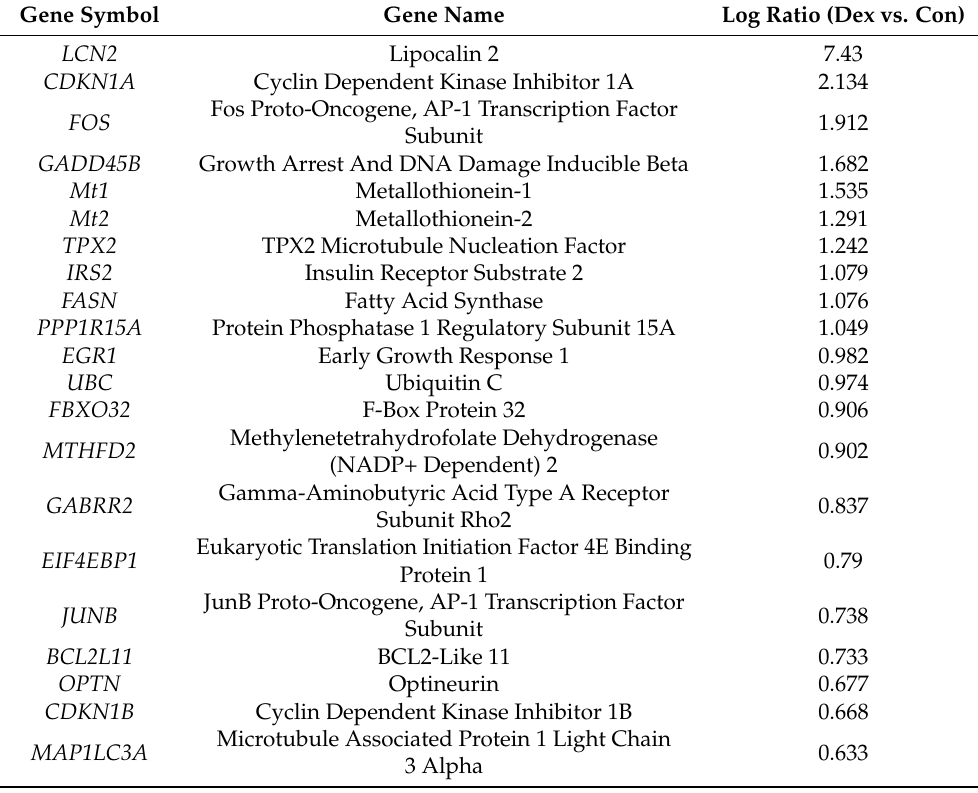
Table 1. Gene list of